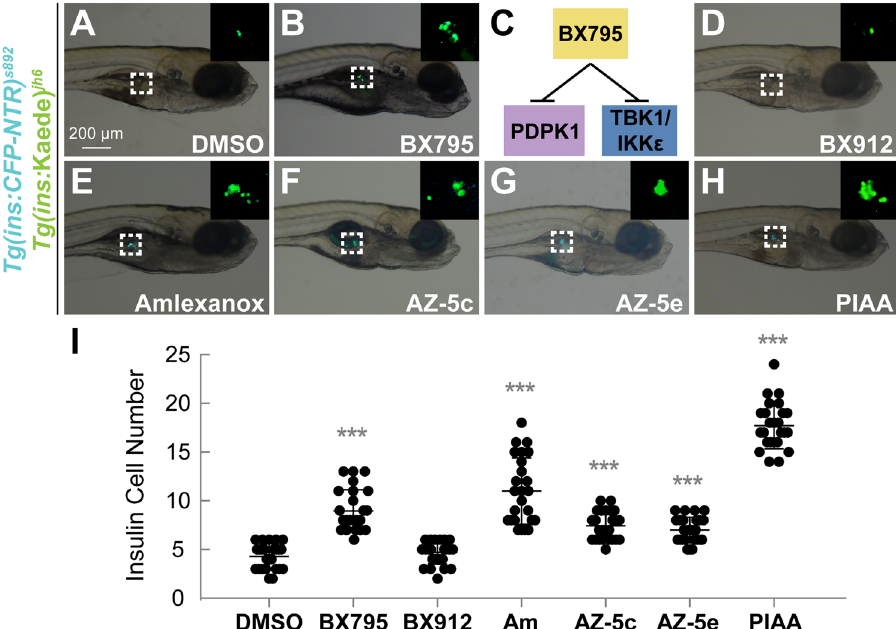
Figure 1. TBK1/IKK ε inhibition augments β -cell regeneration in a zebrafish model of type 1 diabetes. ( A , B , D – H ) Bright-field images combined with fluorescent images showing the overall morphology and [ Tg ( ins :CFP-NTR) s892 ; Tg ( ins :Kaede) jh6 ] expression (green) of larvae at 48 hpa treated with DMSO ( A ), BX795 ( B ), BX912 ( D ), amlexanox ( E ), AZ-5c ( F ), AZ-5e ( G ), and PIAA ( H ), respectively. While TBK1/IKK ε -Is substantially expanded [ Tg ( ins :CFP-NTR) s892 ; Tg ( ins :Kaede) jh6 ]-expressing cell population (white squares and insets) during regeneration ( B and E – H ) compared to DMSO ( A ), the PDPK1 inhibitor BX912 showed minimum effect ( D ). ( C ) BX795 is a dual inhibitor of PDPK1 and TBK1/IKK ε . ( I ) Quantification of the number (mean ± SD) of total regenerated β -cells at 48 hpa (in A-B and D-H; 4.3 ± 1.3 (DMSO), 9.0 ± 2.2 (BX795), 4.7 ± 1.2 (BX912), 11.0 ± 3.4 (amlexanox), 7.4 ± 1.4 (AZ-5c), 7.0 ± 1.3 (AZ-5e), and 17.7 ± 2.4 (PIAA)). Cells in 20 planes of confocal images from 25 individual larvae were counted per condition. *** P <